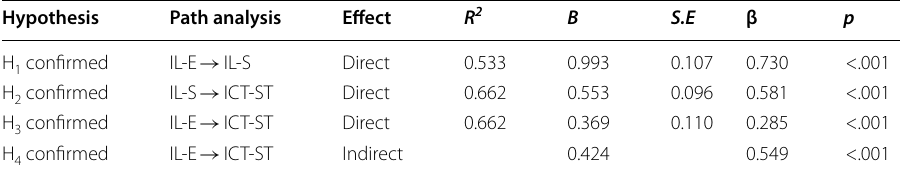
Table 10 Standardized and unstandardized coefficients of structural model: ICT self-efficacy in teaching; information searching; information evaluation